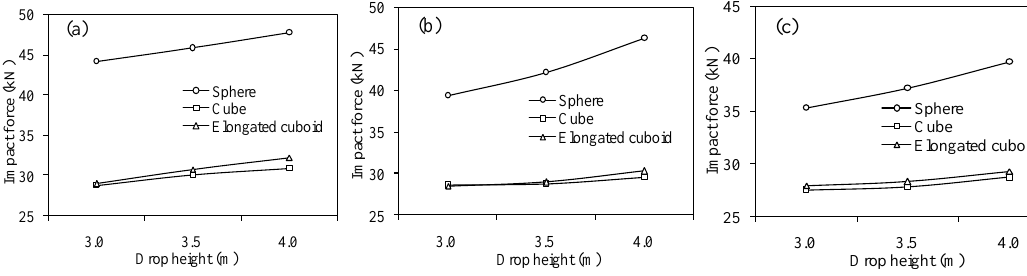
Figure 7. Impact force vs. drop height for samples with different weights: sample weight = (a) 6kg, (b) 5kg, and (c)